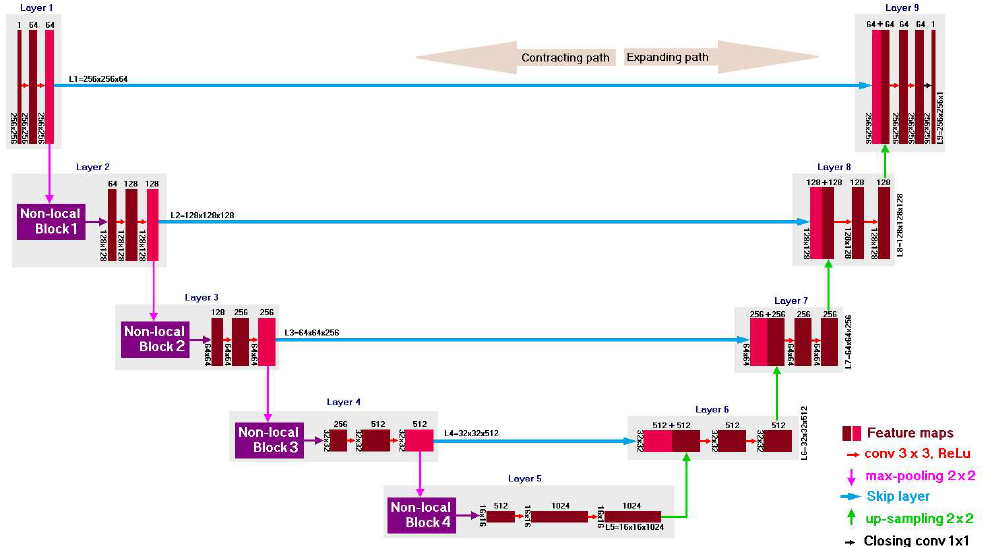
Figure 6. Our adopted non-local block